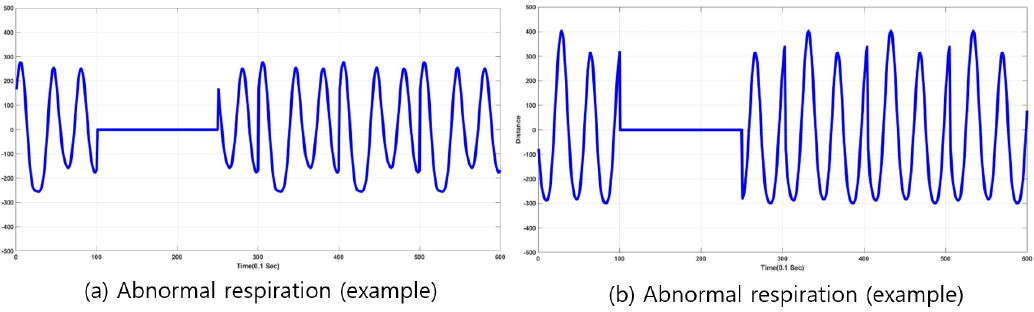
Figure 8. ( a , b ) Two examples of abnormal respiration, apnea